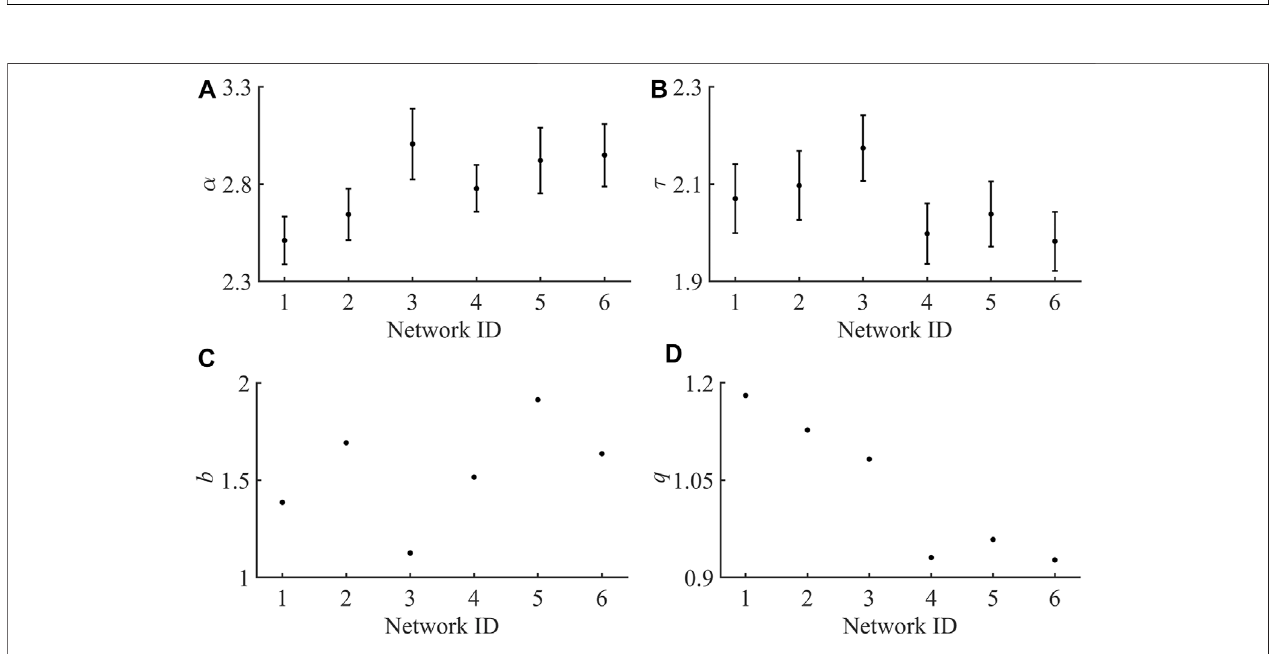
FIGURE 3 | Plots for each individual exponent across all six hNT astrocyte networks. (A) Duration distribution exponents ( α ). (B) Size distribution exponent ( τ ). (C) ) . (Error bars represent the standard deviation in the estimate). Shape collapse exponent (B) . (D) The Scaling relation ( q (cid:2) σν z ( α − 1 ) ( τ − 1 )